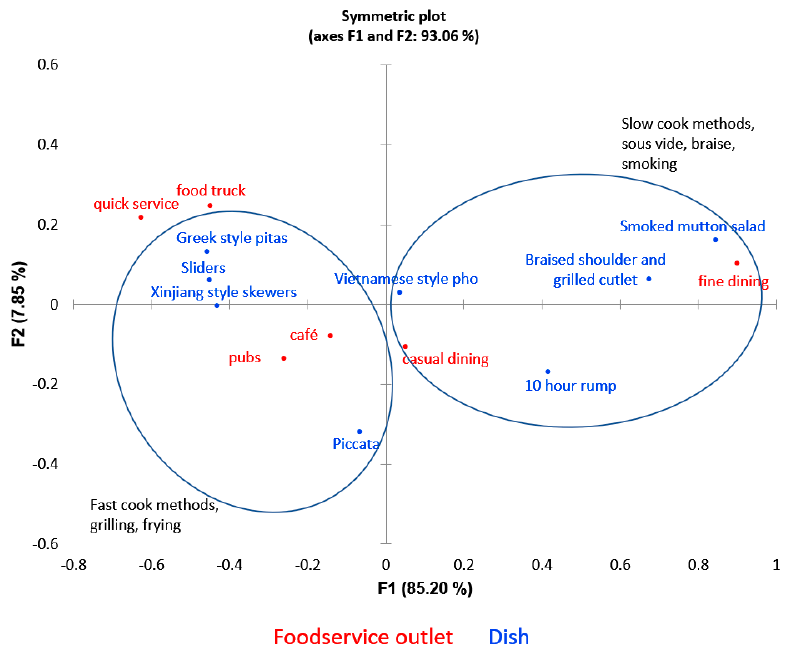
Figure 1. Correspondence analysis of dishes and foodservice outlets.